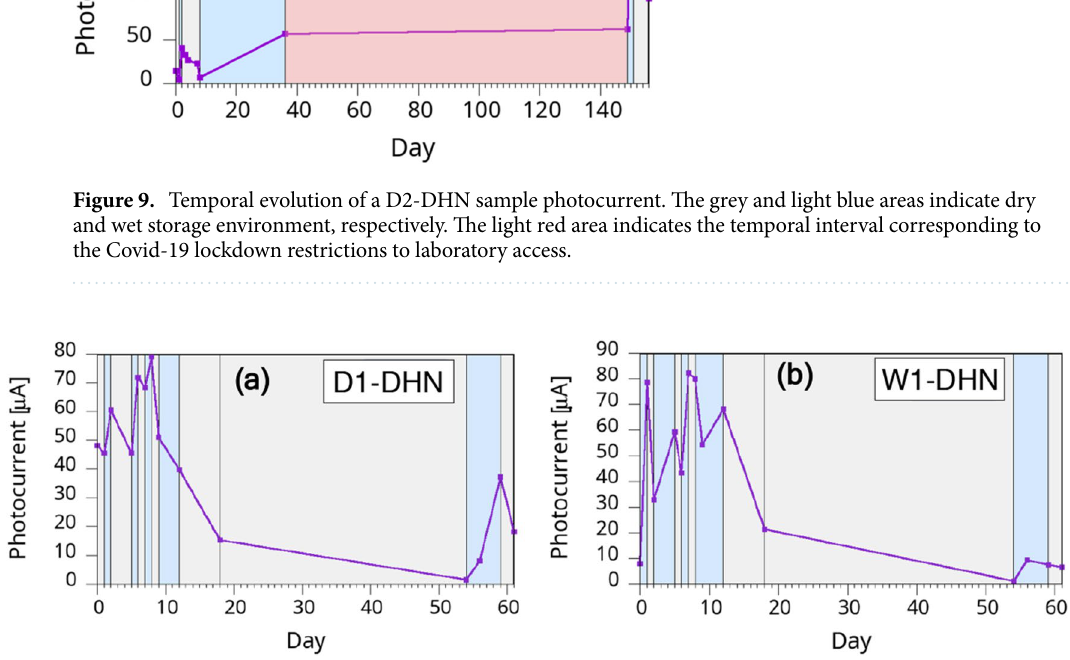
Figure 10. Long-term evolution of the ( a ) D1-DHN and ( b ) W1-DHN samples shown in Fig. 6. The grey and light blue areas indicate dry and wet storage environment,